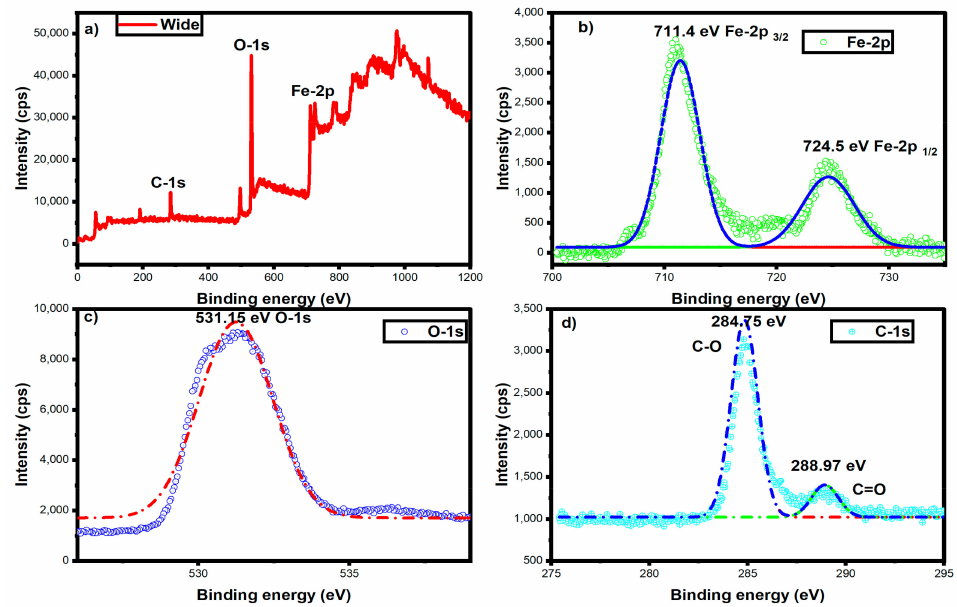
Figure 8. XPS ( a ) wide, ( b ) Fe-2p, ( c ) O-1s, and ( d ) C-1s spectrum of FNH